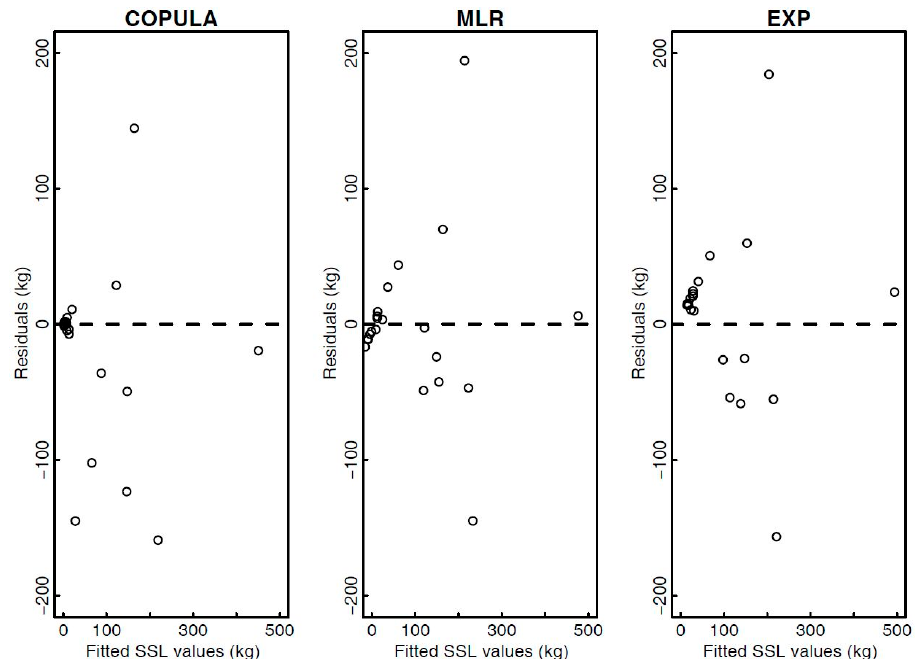
Figure 6. Diagnostic plots showing residuals versus fitted values for three tested models (Copula, EXP and MLR) for the Kuzlovec torrent. Table 3. Performance criteria results and summary statistics for the estimated SSL values for the Kuzlovec torren. Statistic/Model